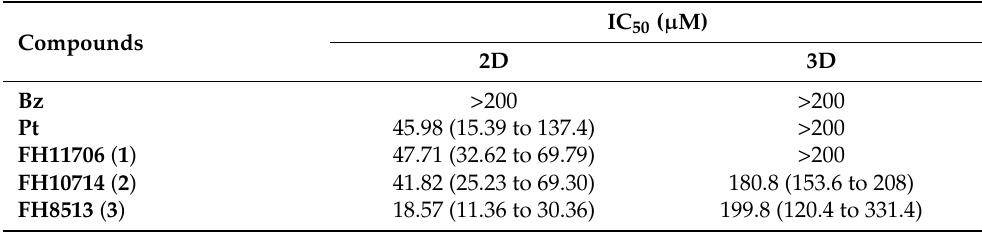
Table 3. Cardiotoxic profile (IC 50 ) of the studied compounds using 2D and 3D cultures of H9C2 after seven days of compound incubation.